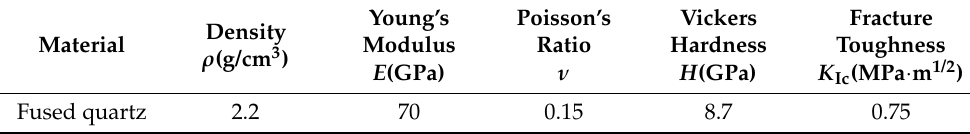
Table 1. Material properties of fused quartz [25].